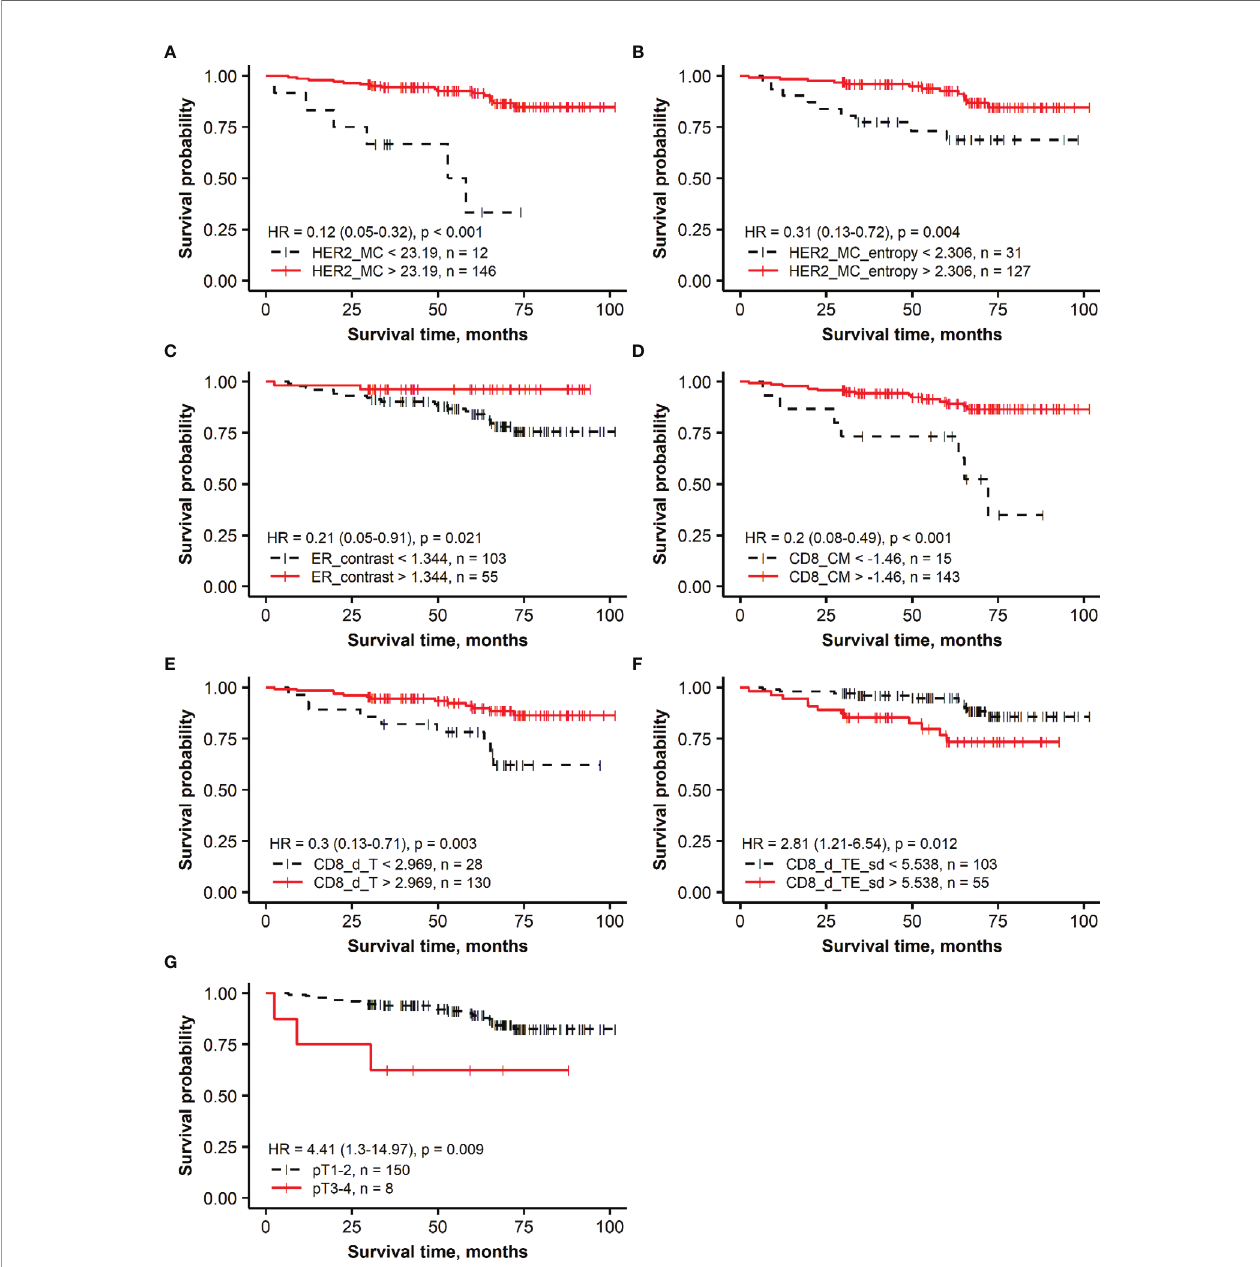
FIGURE 1 | Kaplan – Meier survival plots representing the association of overall survival in the group of patients with HER2 non-ampli fi ed breast cancer with independent prognostic indicators identi fi ed by multiple Cox regression analysis: (A) membrane completeness (HER2 MC), (B) membrane completeness entropy (HER2 MC entropy), (C) ER contrast, (D) center of mass for CD8 density (CD8_CM), (E) mean CD8 density in the tumor aspect (CD8_d_T), (F) SD of CD8 density in the tumor edge aspect (CD8_d_TE_sd), and (G) tumor stage